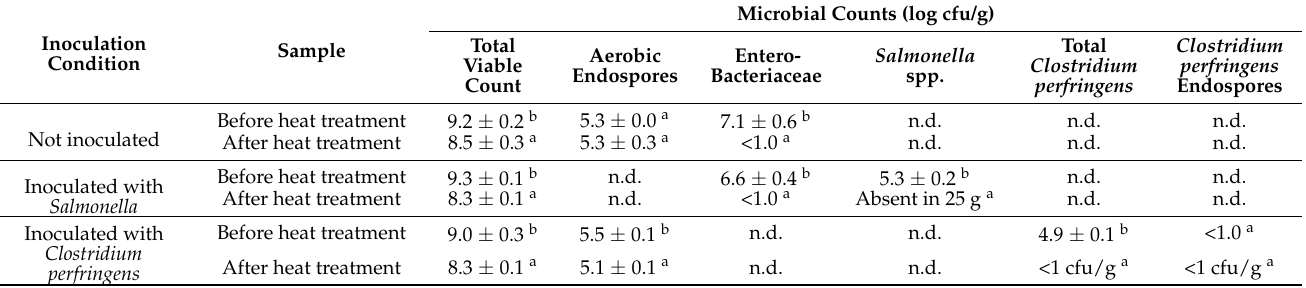
Table 3. Microbial counts for uninoculated and inoculated frass samples before and after heat treatment. Results are presented as the mean of three experiments x two replicates per experiment ( n = 6) ± standard